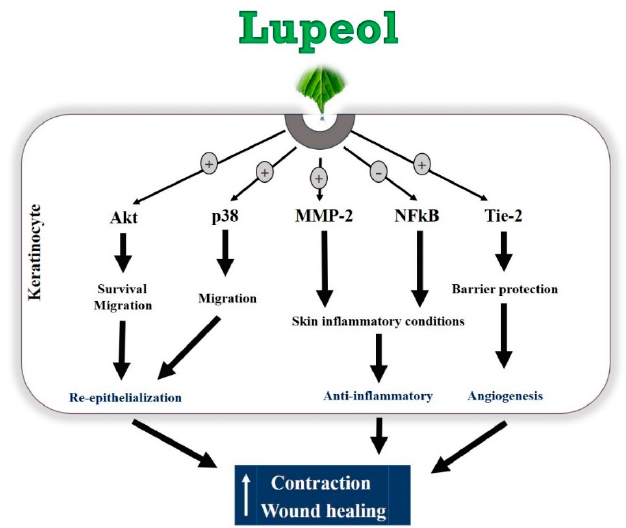
Figure 10. Hypothetical model of the regulatory mechanisms of lupeol in human keratinocytes on wound healing. wound